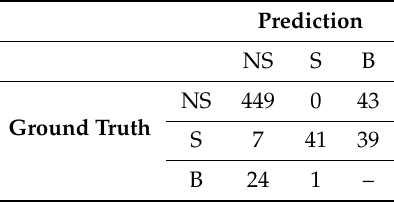
Table 11. Object Detection Confusion Matrix Deeplab v3+.